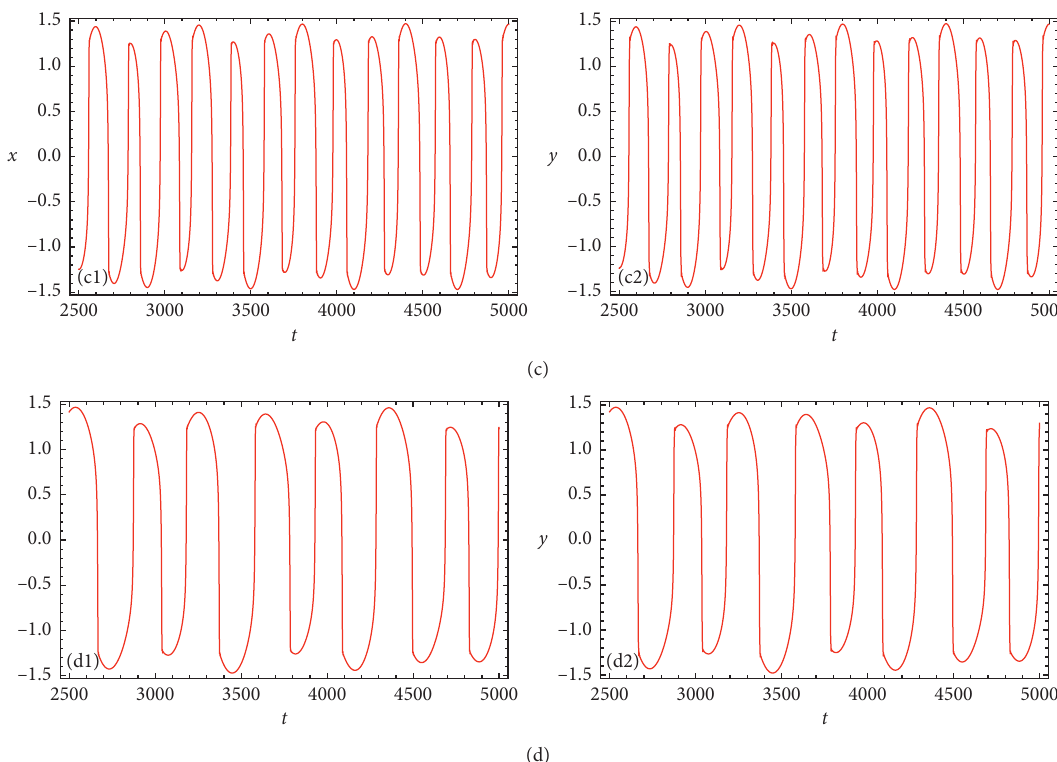
Figure 11: Time series of the bursting for δ ( b , b ) ω � 0 . 01, ω 1 2 1